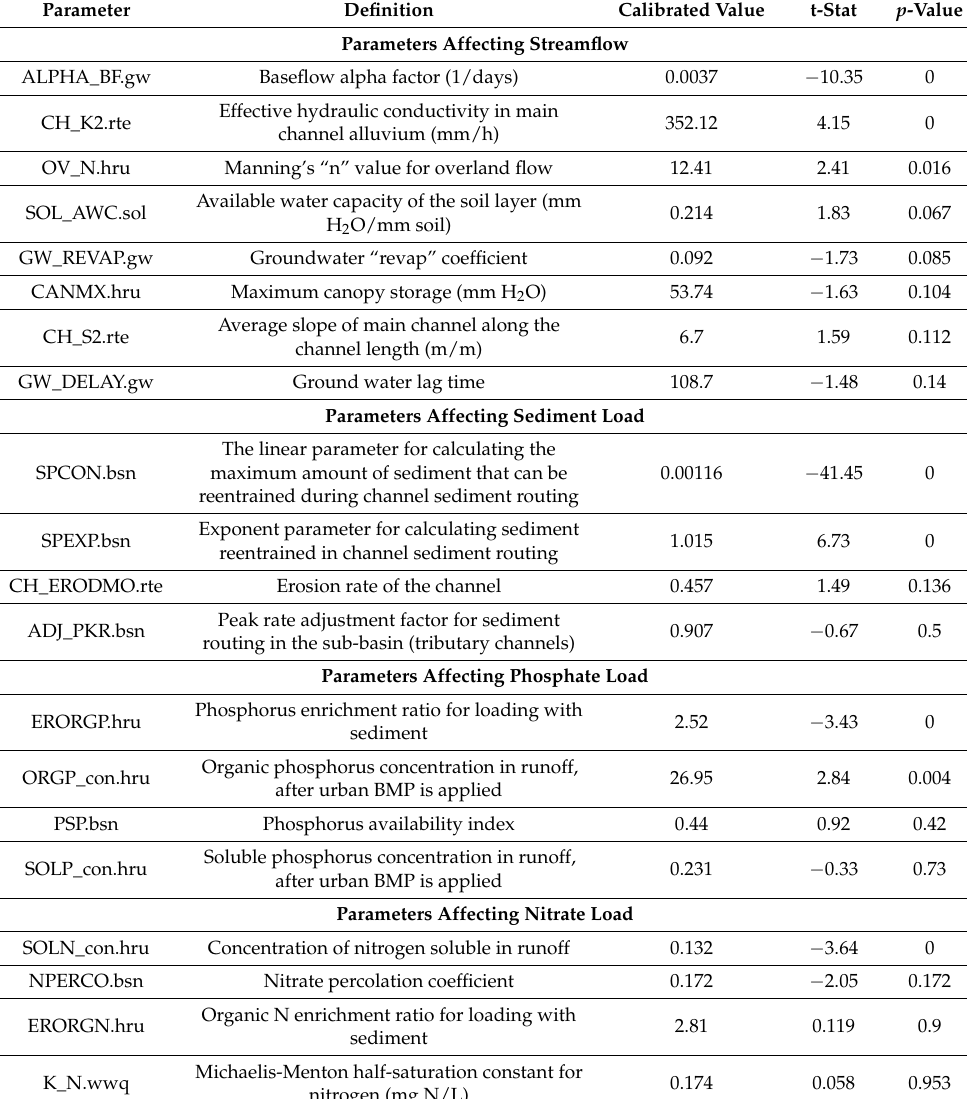
Table 2. Sensitive parameters, and the calibrated values for runoff, sediment, phosphate, and